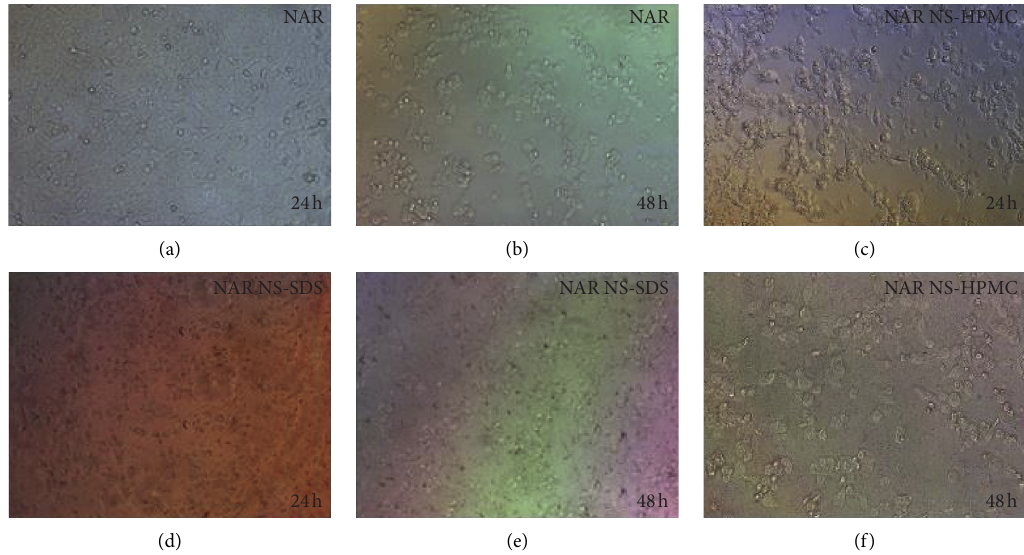
Figure 8: MCF-7 cells were incubated with naringenin solution, HPMC-, and SDS-stabilized naringenin nanosuspension formulations at 100 µ g/ml to induce morphological changes: (a) 24 hours (NAR); (b) 48 hours (NAR); (c) 24 hours (NAR-NS-HPMC); (d) 24 hours (NAR- NS-SDS); (e) 48 hours (NAR-NS-SDS); (f) 48 hours